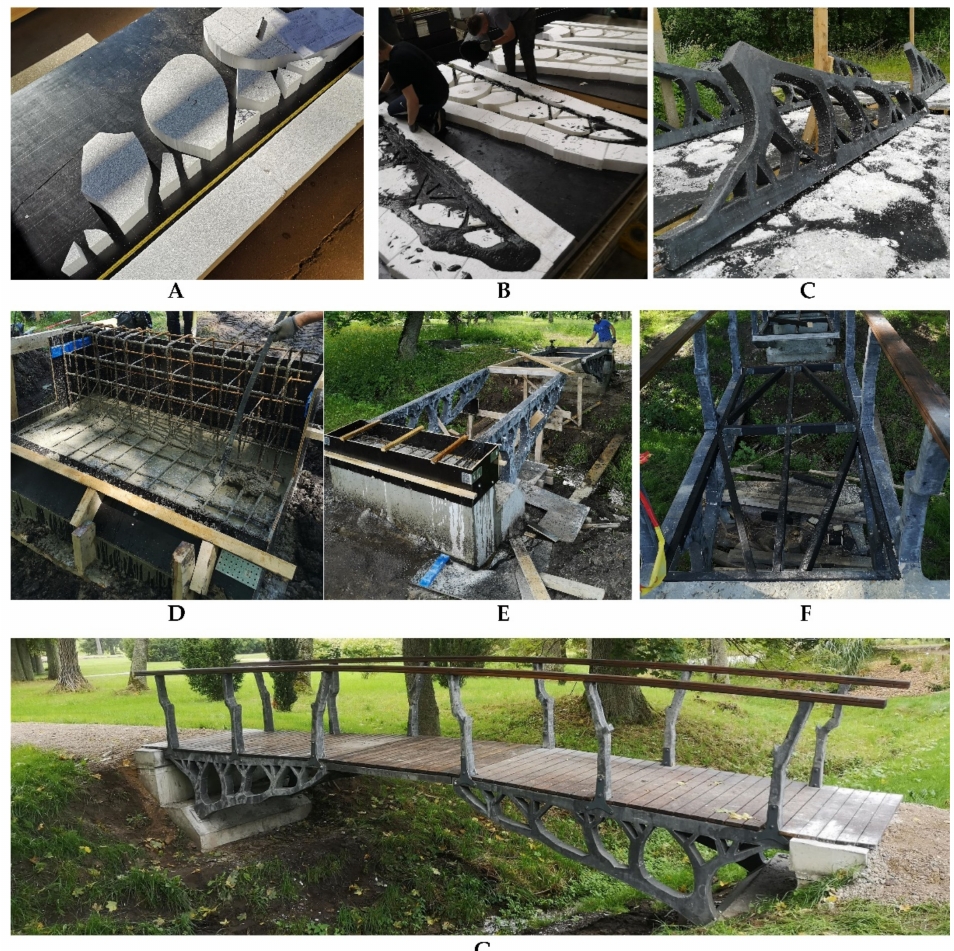
Figure 7. The construction of a prototype footbridge: ( A ) preparation of formwork; ( B ) pouring UHPC mix; ( C ) demolding UHPC trusses; ( D ) construction of foundation; ( E ) installation of UHPC trusses; ( F ) trusses connected with braced timber frame; ( G ) finished prototype